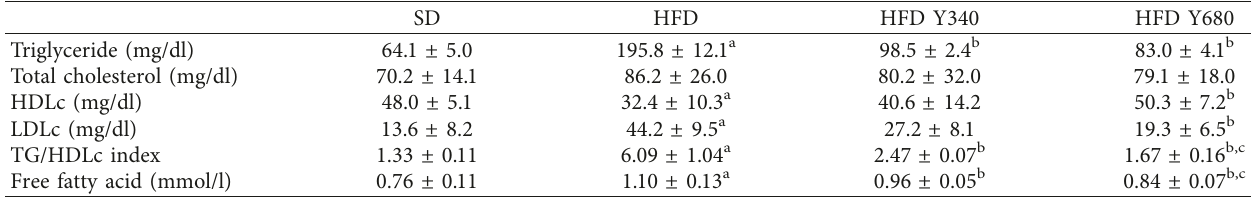
Table 2: Effects of yacon supplement on serum lipid profile of HFD-fed rats.